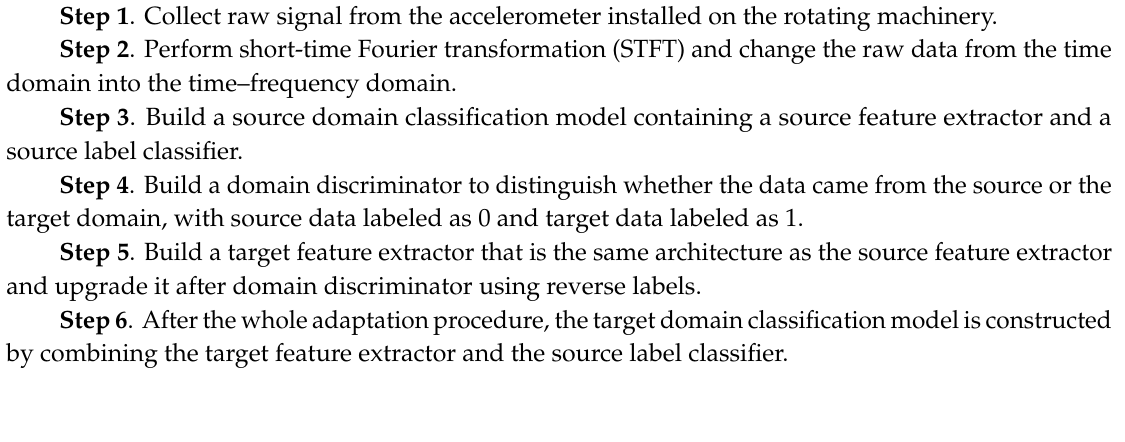
Figure 1. Schematic of the proposed generative transfer learning (GTL) method.